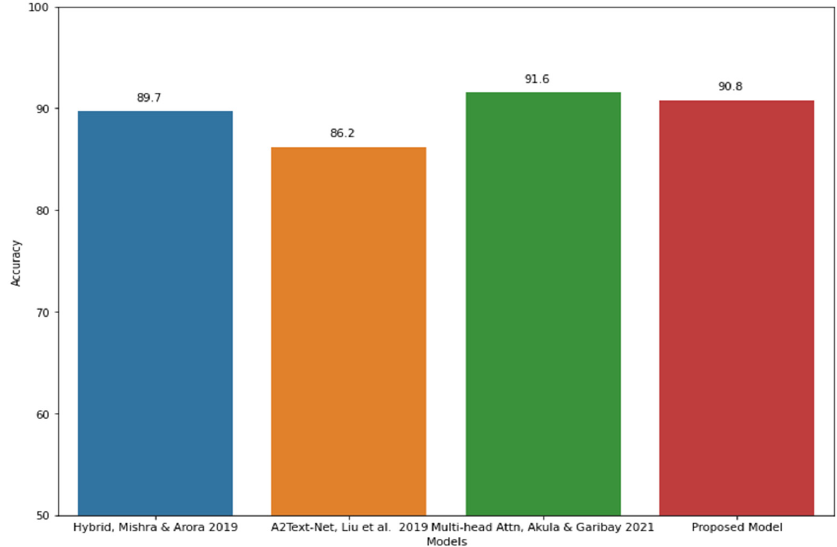
Figure 15. Accuracy comparison of previous research [24–26] over headlines dataset.